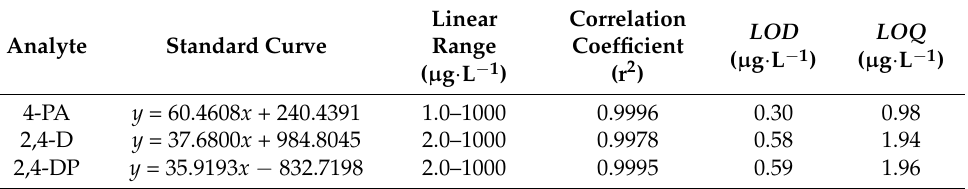
Table 2. Analytical parameters of MSPE-HPLC-UV method for the determination of phenoxy car- boxylic acid pesticides in standard solution.